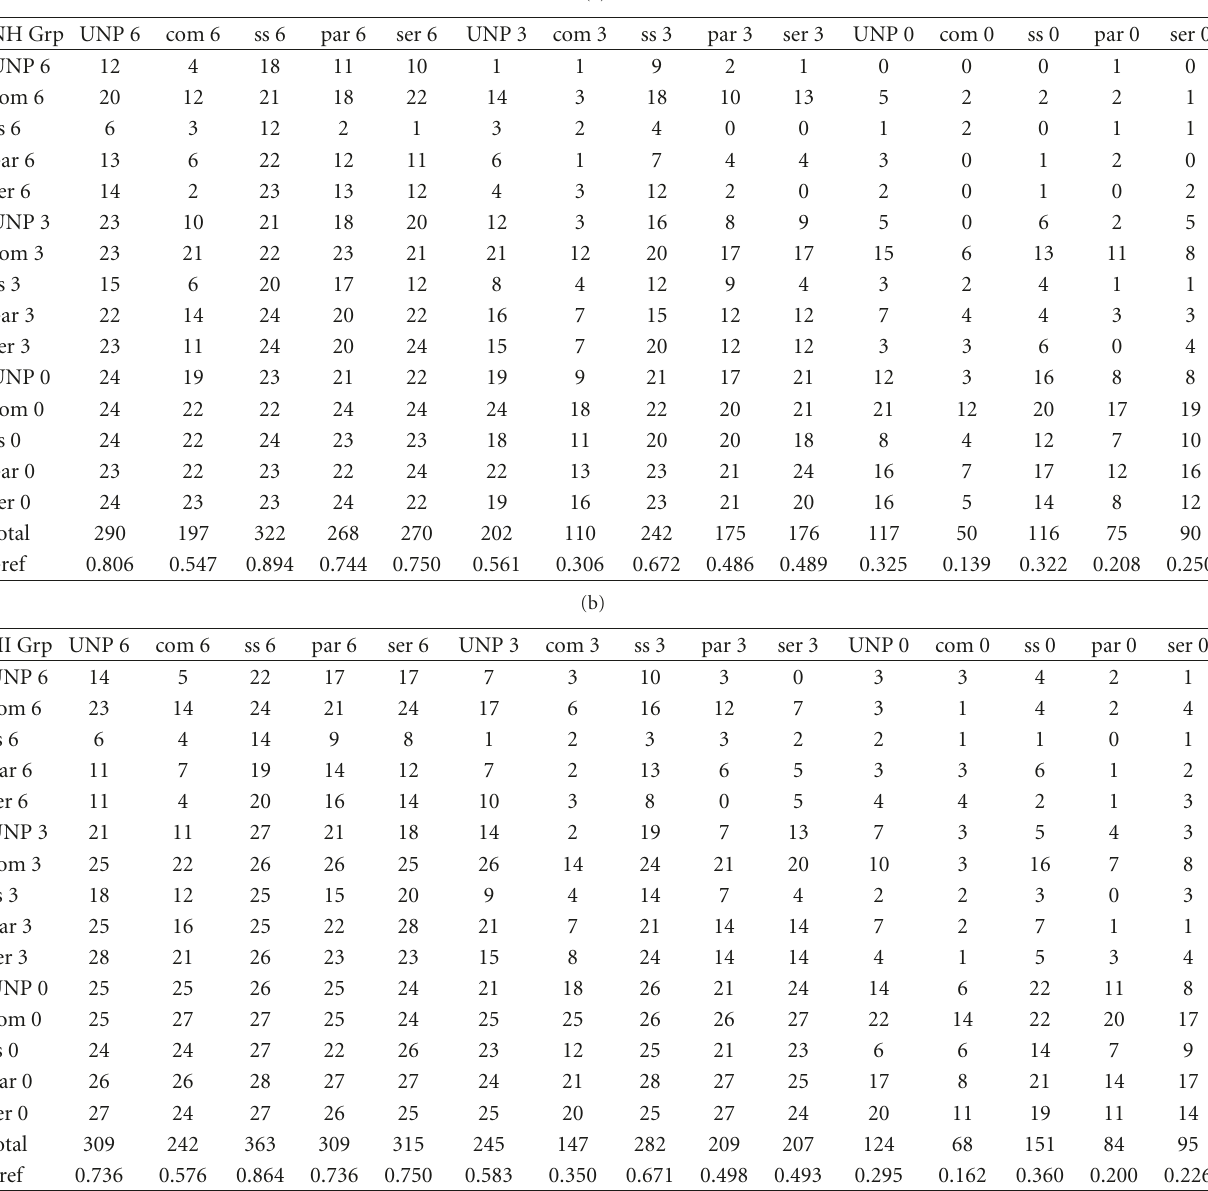
Table 3: Preferences for processing conditions. The NH group is represented in the top panel, with the HI group represented in the bottom panel. UNP = unprocessed, com = compression, ss = spectral subtraction, par = parallel, and ser = series.